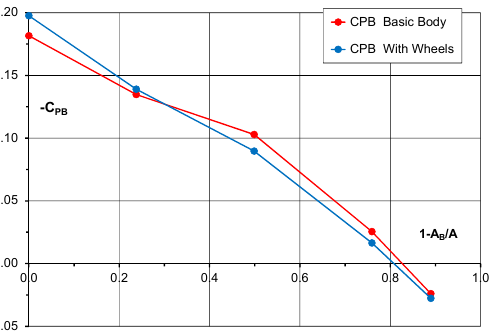
Figure 11. Base pressure coefficient for 2D taper case, with and without wheels.